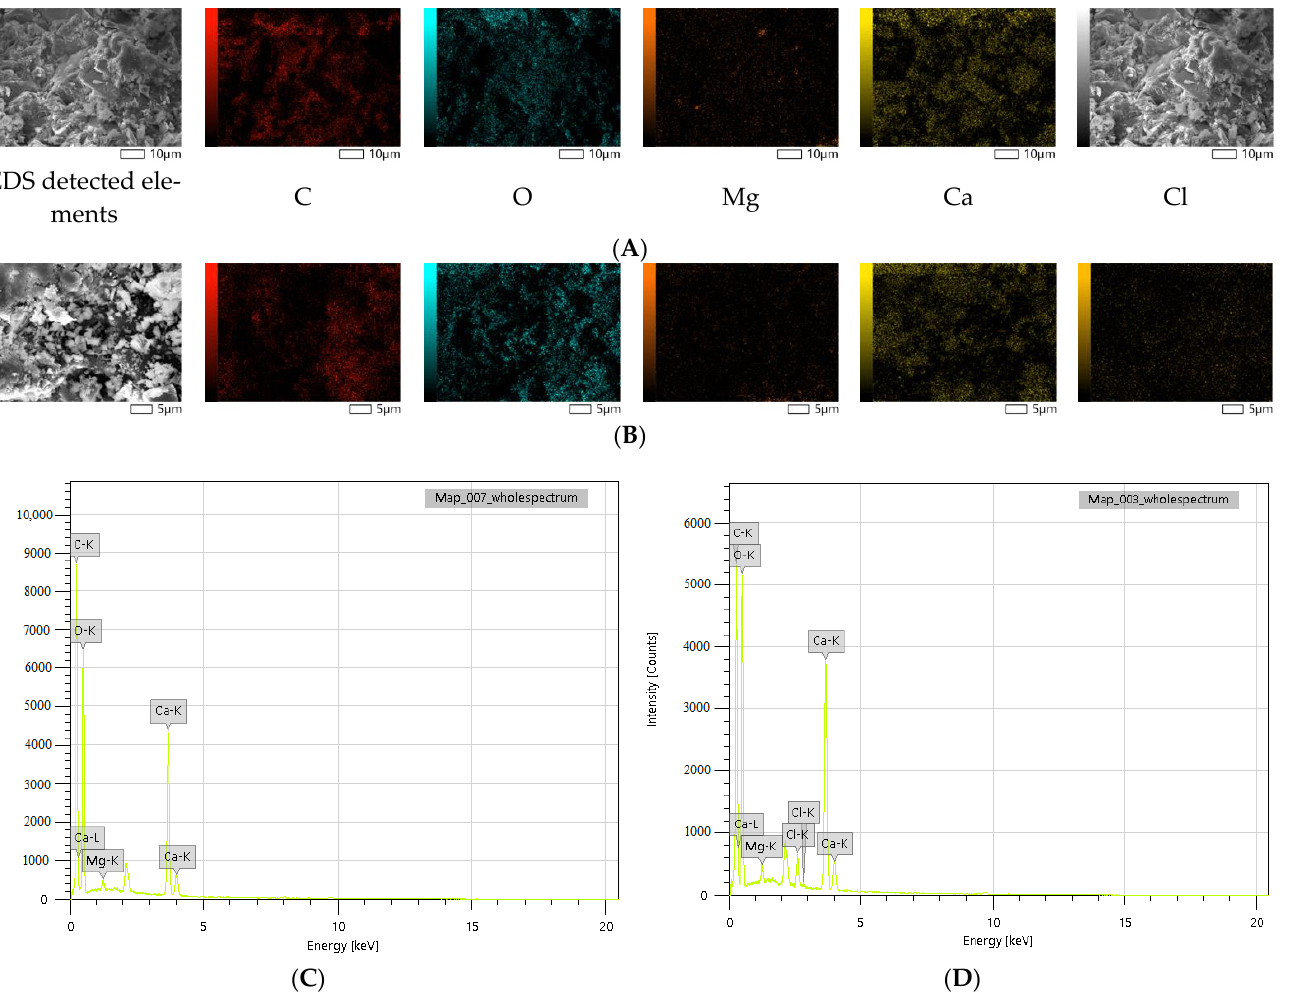
Figure 4. SEM-EDS micrographs of the reference ( A , C ) and 5 wt.% triclosan-loaded ( B , D ) polymer composites.